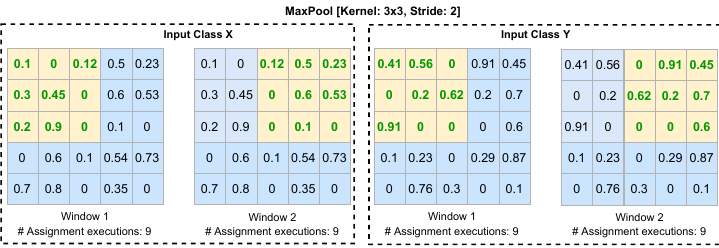
Figure 13: An example of constant number of assignment operations for two different inputs during Maxpool operation after implementing